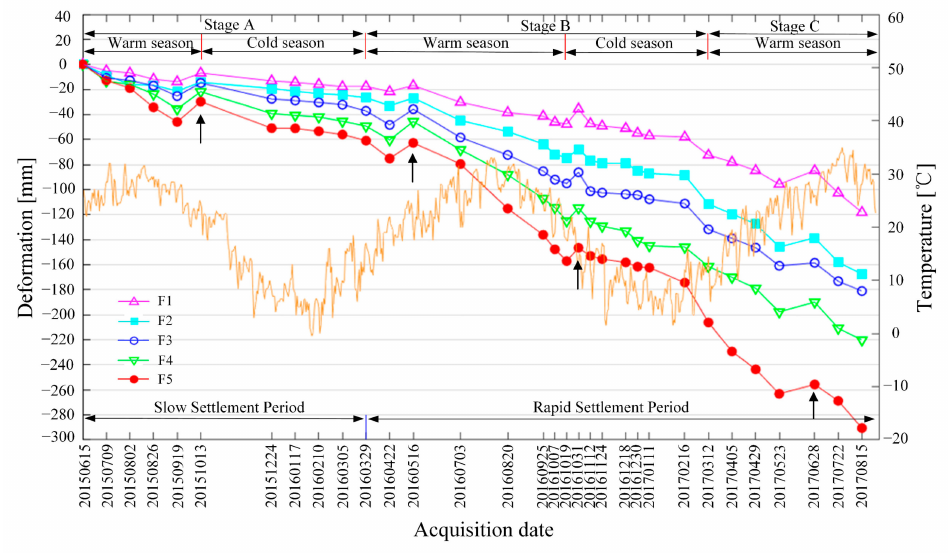
Figure 20. Time series settlement on feature points based on